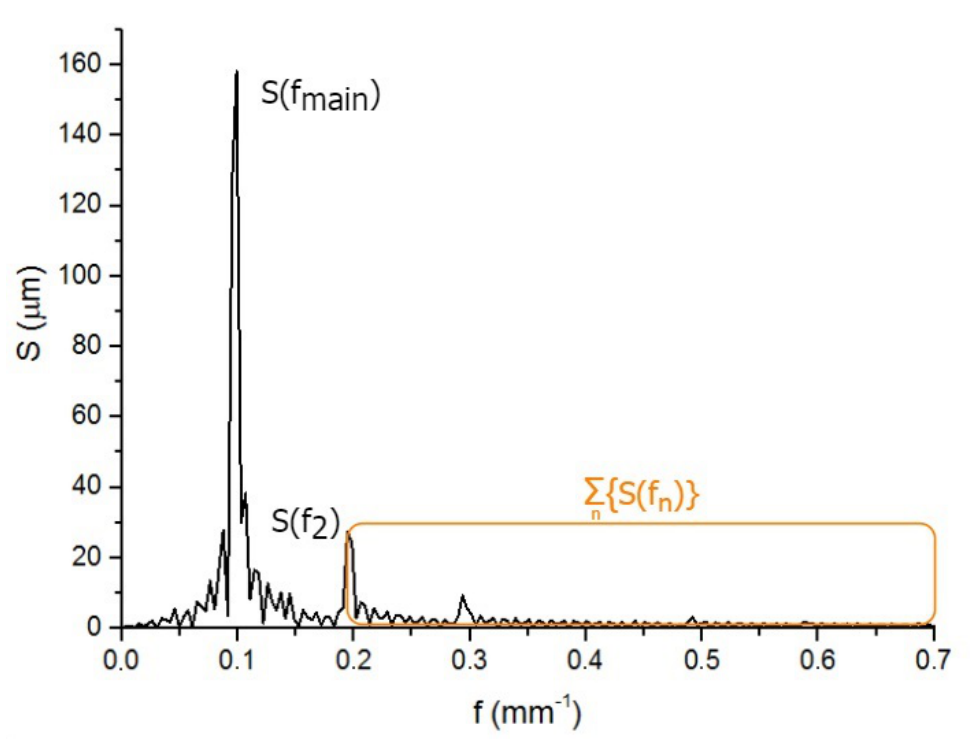
Figure 5. The components of spectral metrics labeled by the example of the profile